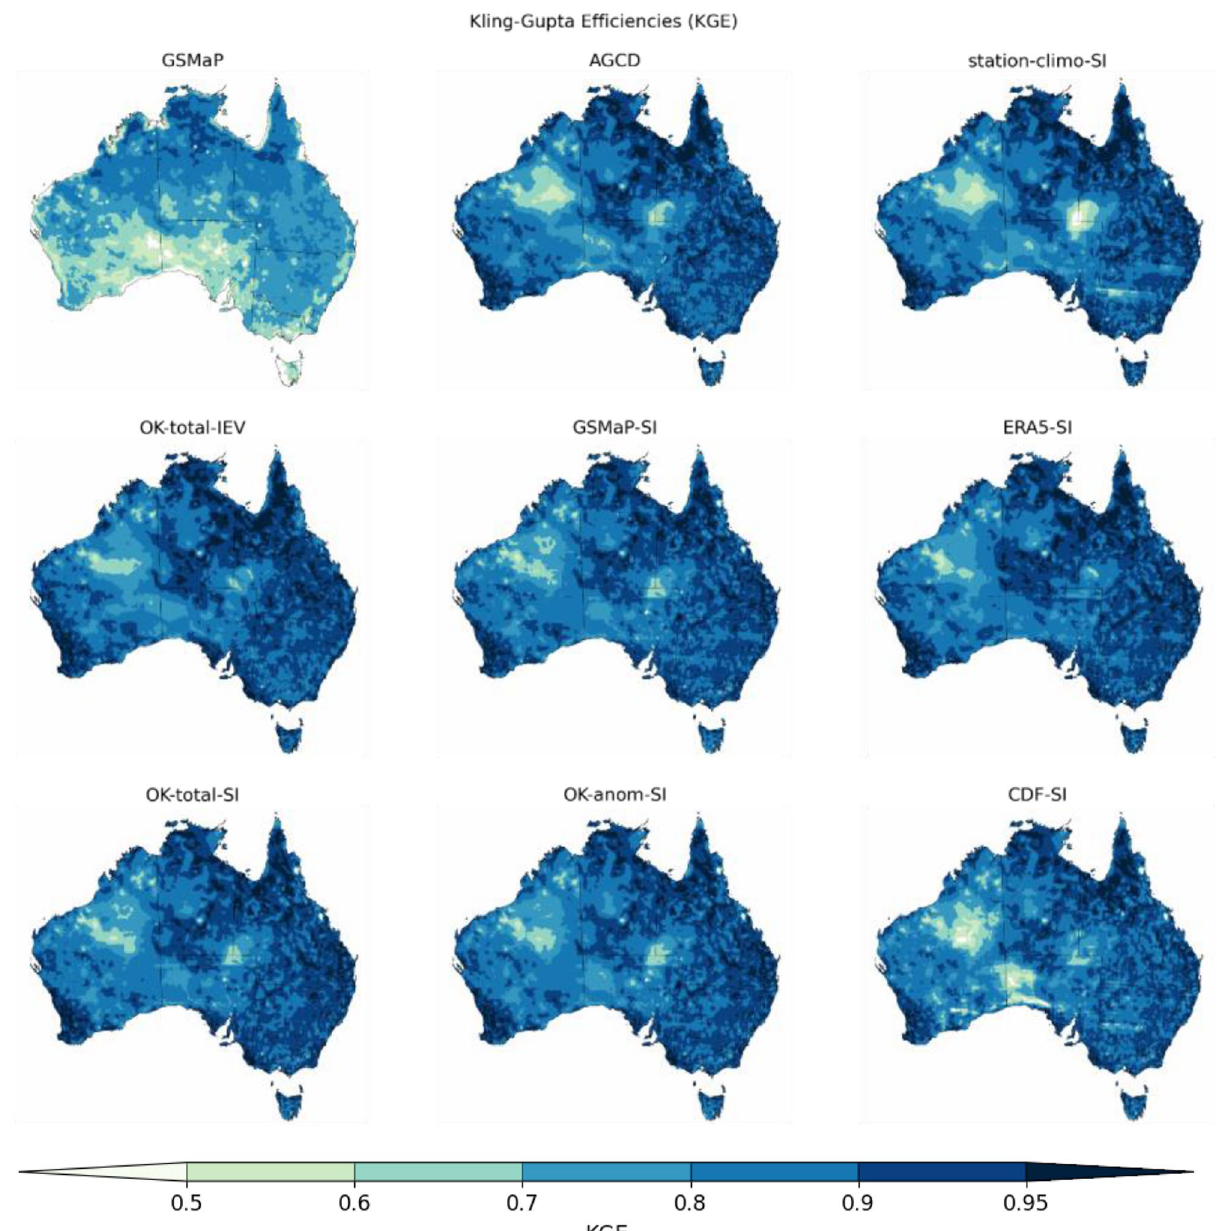
Figure 5. Kling-Gupta Efficiencies (KGE) of the datasets over the domain of Australia. A value of unity is ideal. The satellite-SI datasets have improved KGEs over northern interior of Western Australia, where gauge density is very low. Figure created using Matplotlib 3.3.3 on